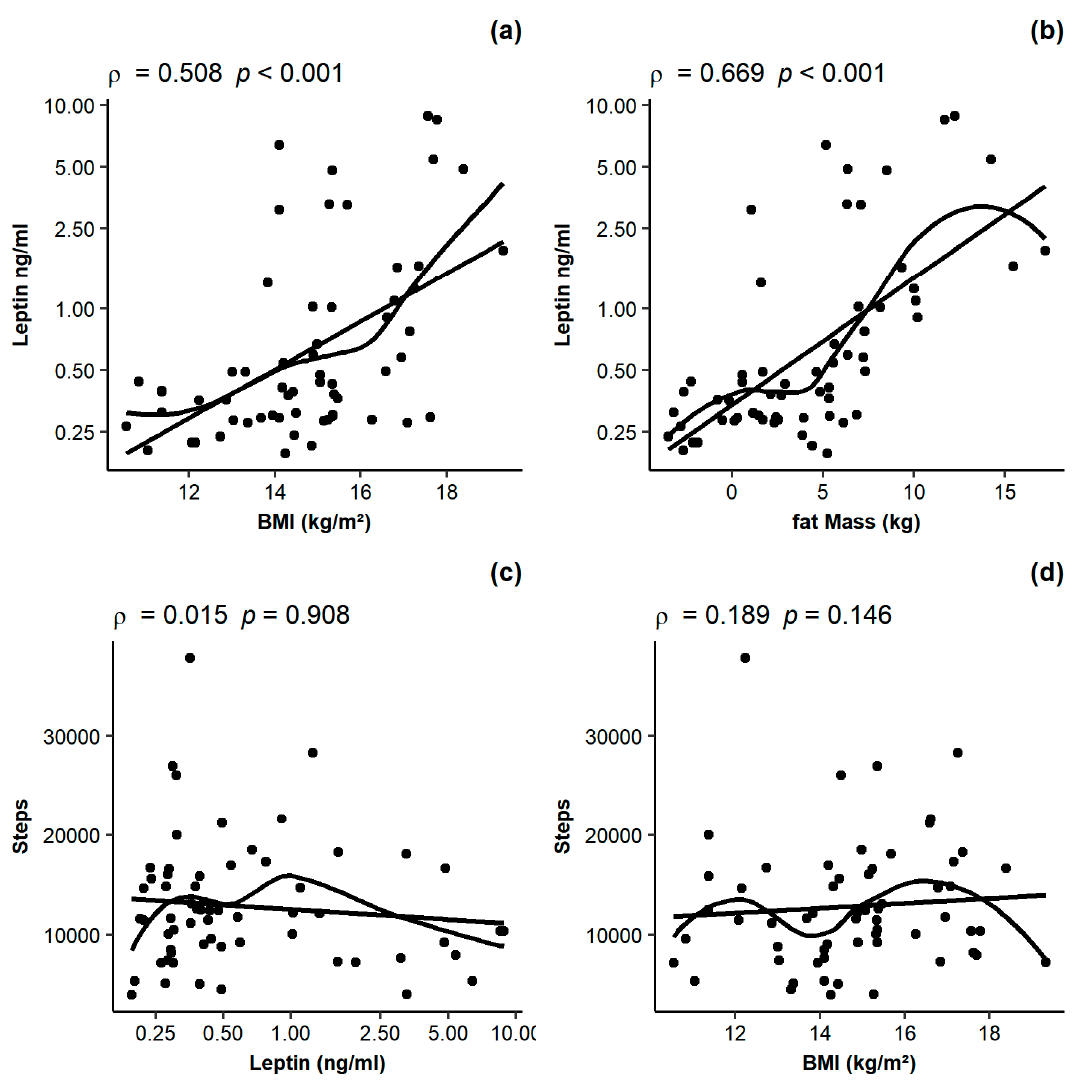
Figure 1. Associations between leptin and BMI ( a ), leptin and fat mass ( b ), steps and leptin ( c ) and steps and BMI ( d ).